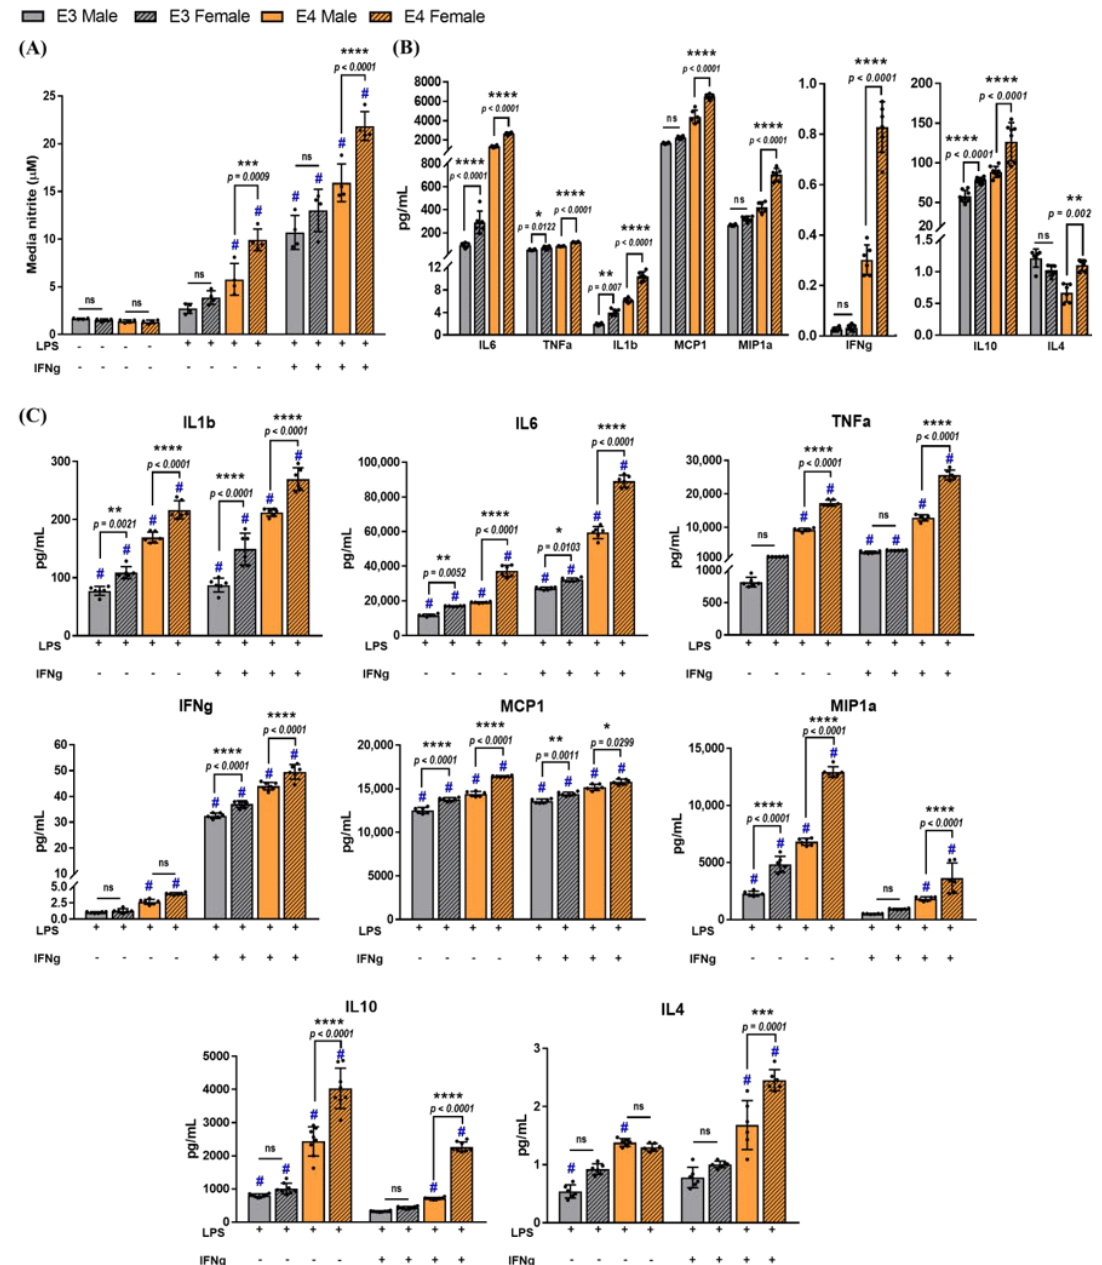
Figure 7. Increased secretion of inflammatory cytokines is dependent on both the APOE genotype and sex: ( A ) average nitrite levels accumulated in the media were measured by GRIESS assay. Three − way ANOVA followed by Tukey’s multiple comparisons test revealed a significant treatment − by − genotype − by − sex effect. # denotes a significant increase compared to the respective genotype control ( p < 0.05). ( B ) Basal levels of secreted cytokines were measured in non − stimulated microglia after 24 h by an MSD multiplex assay. Comparisons between sex and genotype were made using two-way ANOVA followed by Tukey’s multiple comparisons test (N = 3 isolations, n = 6 plates). ( C ) Secretion of cytokines was measured post − treatment with LPS or LPS + IFNg by a three − way ANOVA followed by Tukey’s multiple comparisons test. Data are represented as the mean ± standard deviation. # denotes a significant increase compared to the respective control (data not included in the graphs, p < 0.05). *, **, ***, and **** indicate statistical significance for the comparison and denote p < 0.05, 0.01, 0.001, and 0.0001, respectively. ns = not statistically significant ( p >